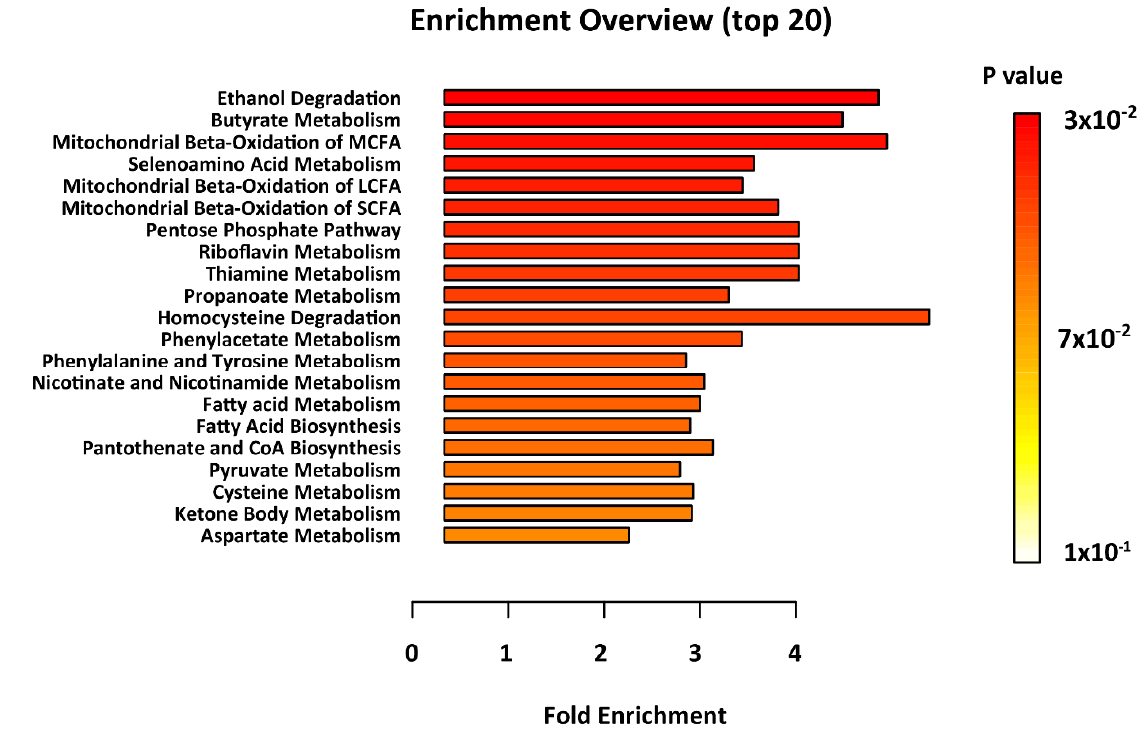
Figure 2. Results of the metabolite set enrichment analysis. Metabolic pathways with p < 0.05 were considered to be significantly perturbed.